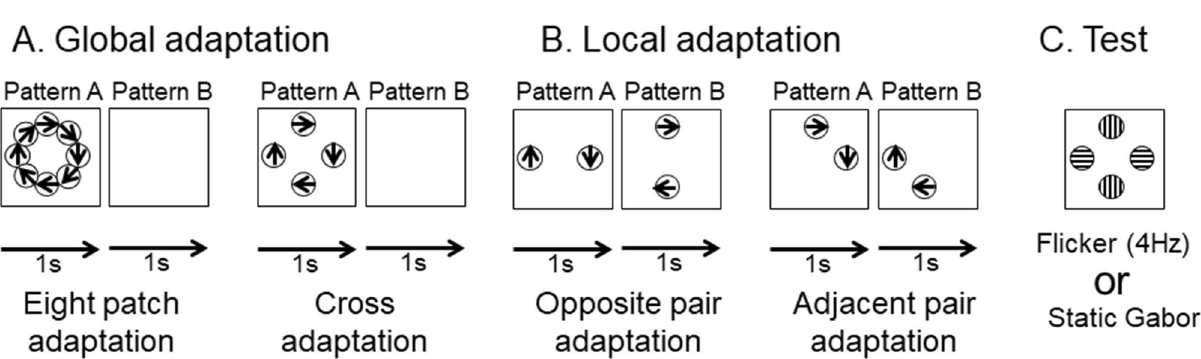
Figure 7. Stimuli of Experiment 3. ( A ) Global Motion Adaptation stimuli. Participants adapted to two alternating displays each consisting of eight or four Gabor patches forming a global rotational motion. Each display remained for 1 s, and the entire adaptation lasted for 10, 20, or 40 s. The presentation order of Patterns A and B were changed in half of sessions to minimize the difference of motion stimulus right before test presentation among conditions. ( B ) Local Motion Adaptation Stimuli. The alternating display was similar to the global motion condition except that each adapting display consisted of only two Gabor patches. The presentation order of Patterns A and B were changed in half of sessions as well. ( C ) The test stimulus was a display consisting of 4 Gabor patches, either static or flickered at 4 Hz. The participants used two keys assigned to opposite directions to report their perceived MAE when the MAE